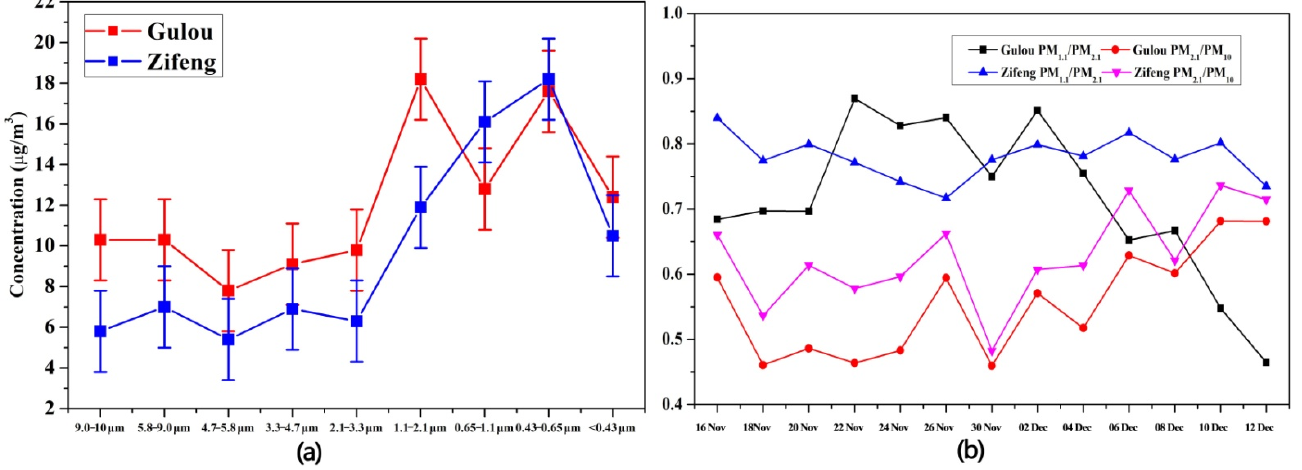
Figure 4. ( a ) The average mass size distributions of PM with standard deviation at Gulou (20 m) and Zifeng (30 m). ( b ) The ratios of PM2.1/PM10 and PM1.1/PM2.1 at Gulou and